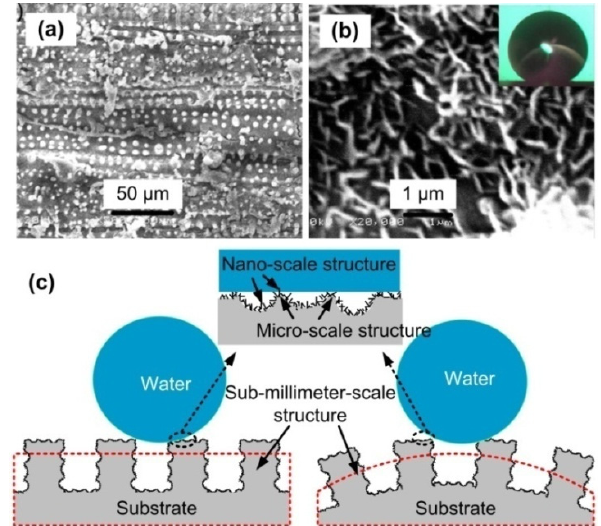
Figure 3. Morphology of rice leaf and schematic diagram of three-level structure: ( a ) and ( b ) SEM images of rice leaf surface, and the inset of ( b ) is a water droplet on the surface with a contact angle of 157° (Reproduced with permission from [43]. Copyright Elsevier, 2011); ( c ) designed plane surface with three-level structure and convex surface with three-level structure.